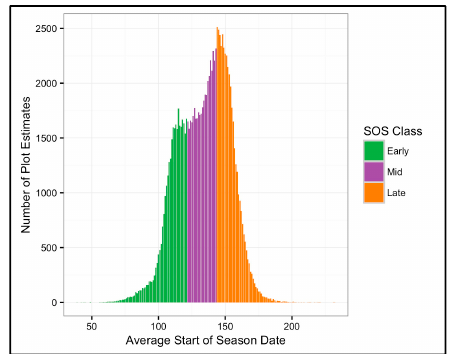
Figure 2. Histogram of the average start of season date (Julian days), which is the average date that pixels reached half of their seasonal amplitude in NDVI [47], for all grassland pixels in the Upper Yellowstone River Basin. This histogram was used to classify pixels into early, mid, and late start of season (SOS)